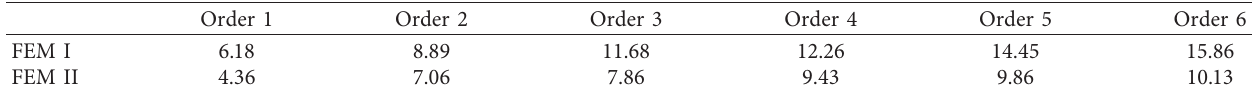
Figure 10: Time history of the acceleration response of point Table 5: Calculated frequencies of two types of FEM.